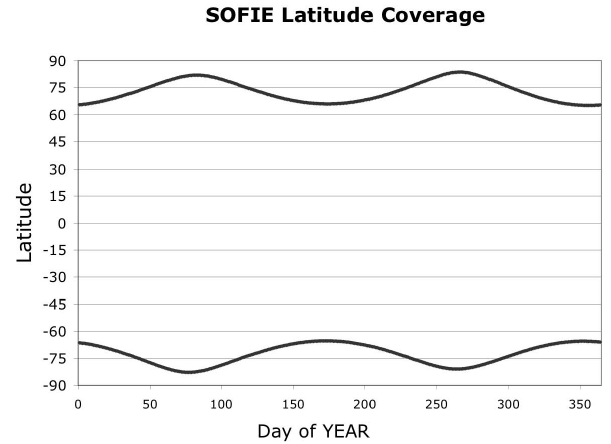
Fig. 28. Impact of PMC correction, right-hand panel shows the difference. Fig. 29. SOFIE tangent-point